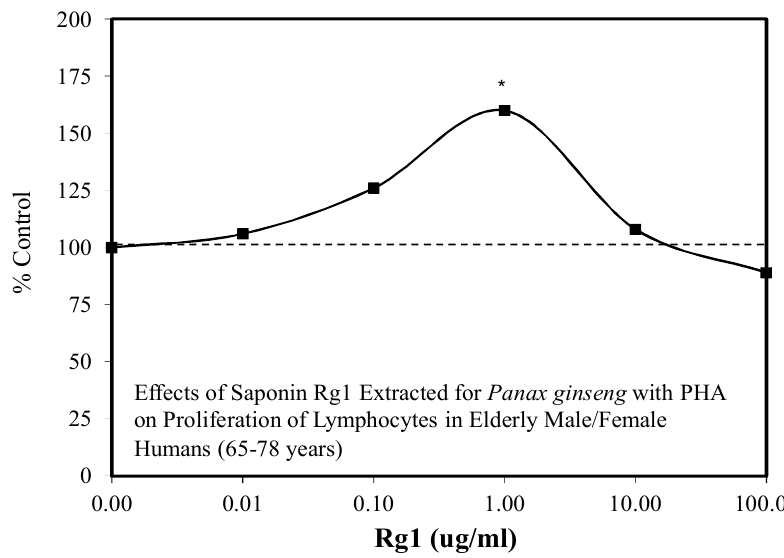
Figure 11. Effects of saponin Rg1 Extracted for Panax ginseng with phytohemagglutinin (PHA) on the proliferation of lymphocytes in elderly male/female humans (65–78 years) (source: [65]). Each * represent statistical significance for a data point.